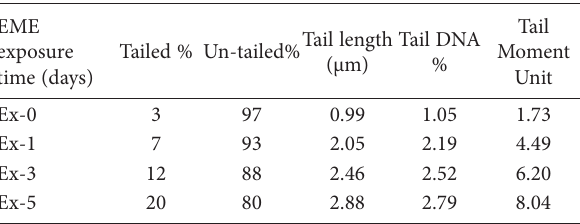
Table 7. Damage extent of nuclear DNA generated by Comet assays in EMF non-exposed and exposed Zea mays nuclei for days of exposure times (Ex-0, Ex-1, Ex-3,and